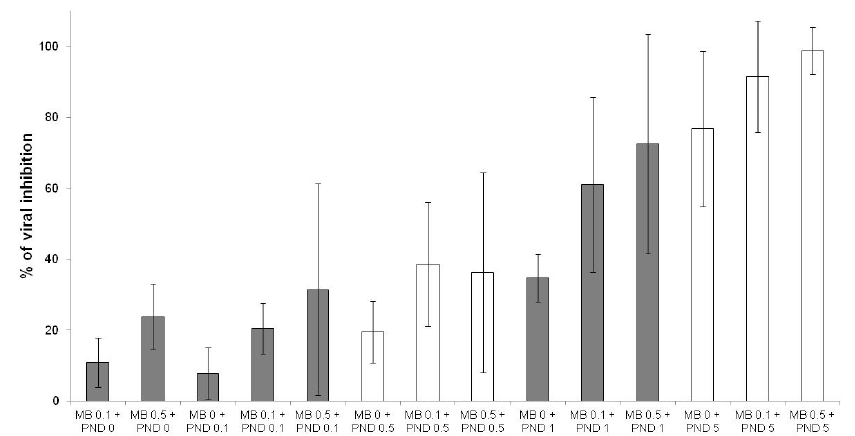
Figure 5. Antiviral activities of methylene blue (MB) at 0.1 and 0.5 µM in combination with pyronaridine (PND) at 0.1, 0.5, 1 and 5 µM (error bars represent standard deviation of 9 independent experiments). The combinations of methylene blue with chloroquine (Figure 6), hydroxychloroquine, desethylamodiaquine, piperaquine, lumefantrine, ferroquine, dihydroartemisinin and remdesivir (data not shown) were antagonist.